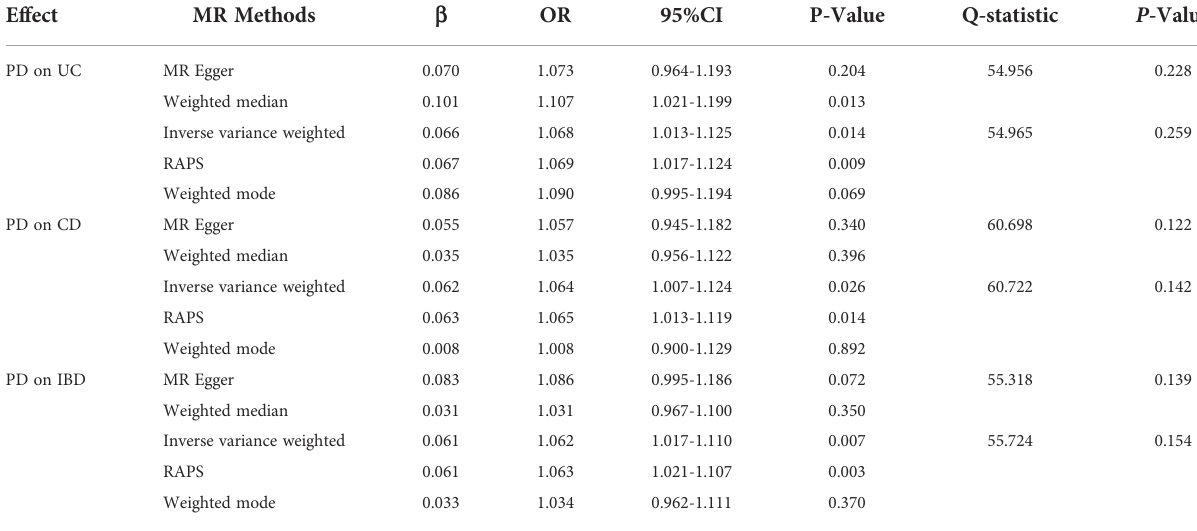
TABLE 1 Mendelian randomization estimates for causal effects of PD on IBD .